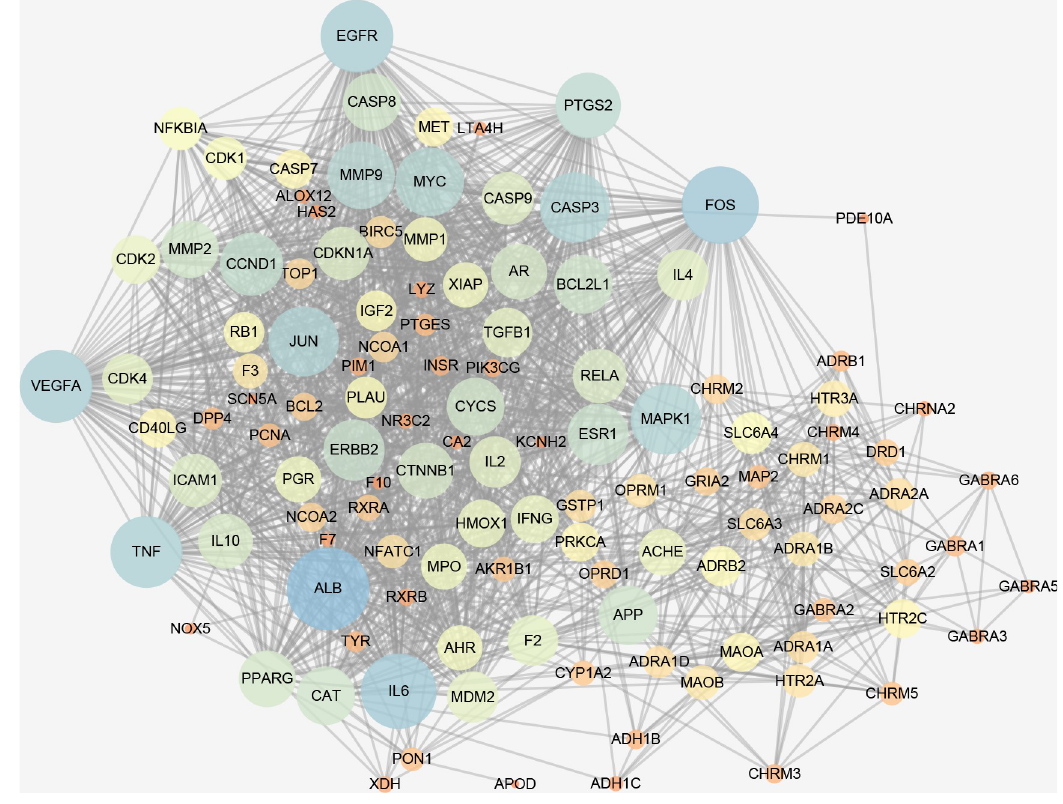
Fig 3. PPI network.